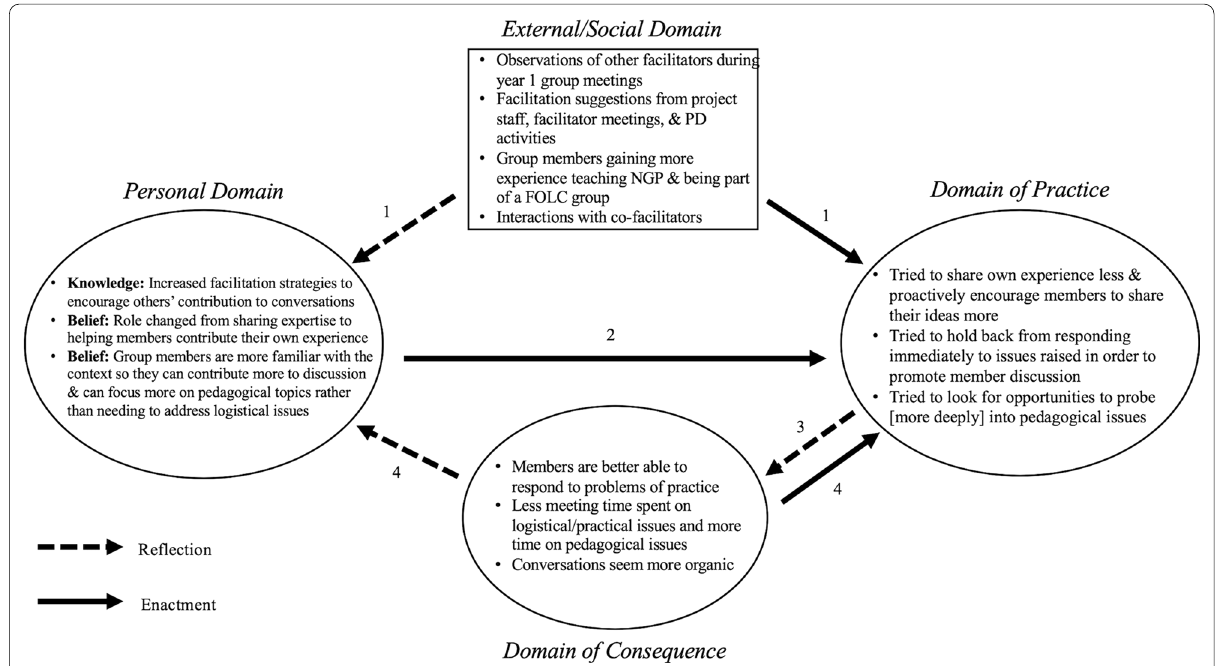
Fig. 10 The IMPG change sequence for Craig as a facilitator over 2